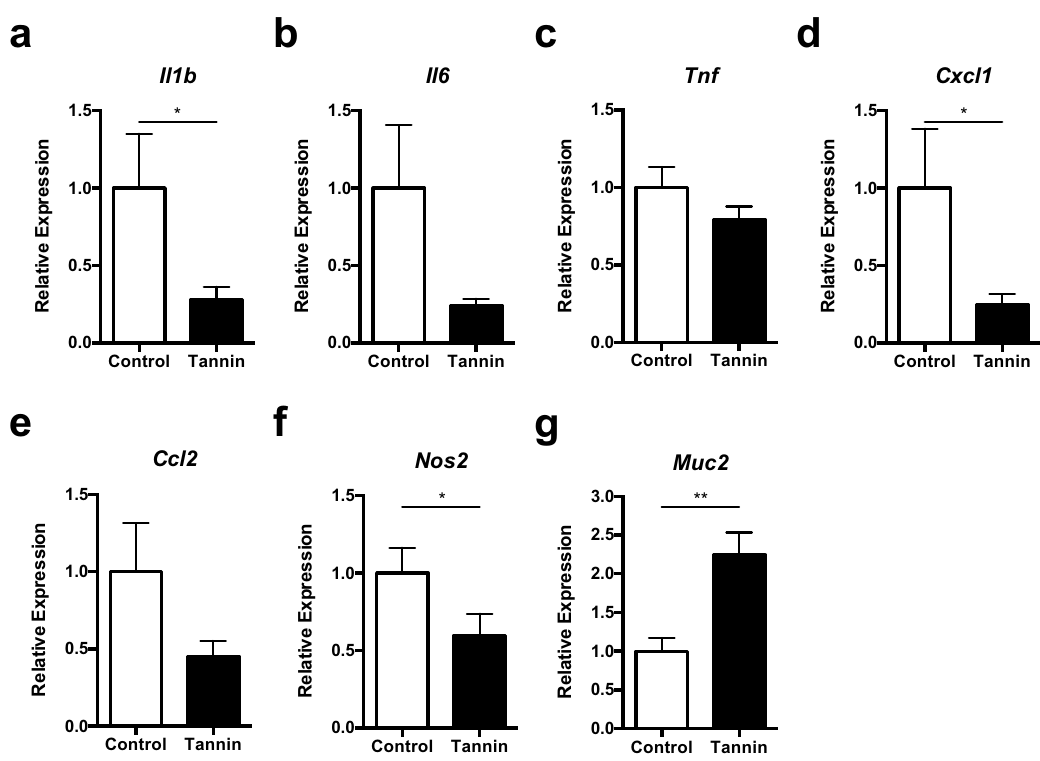
Figure 2. Effect of the tannin-supplemented diet on gene expression in the colon of colitis-induced mice. Transcripts of IL-1β ( a ), IL-6 ( b ), TNF-α ( c ), CXCL1 ( d ), CCL2 ( e ), iNOS ( f ), and Muc2 ( g ) in the colon of colitis-induced mice fed the control or tannin diet were measured by quantitative PCR (normalized with Gapdh ). Data are shown as the mean ± SEM of three independent experiments (n = 19–20). * p < 0.05, ** p <